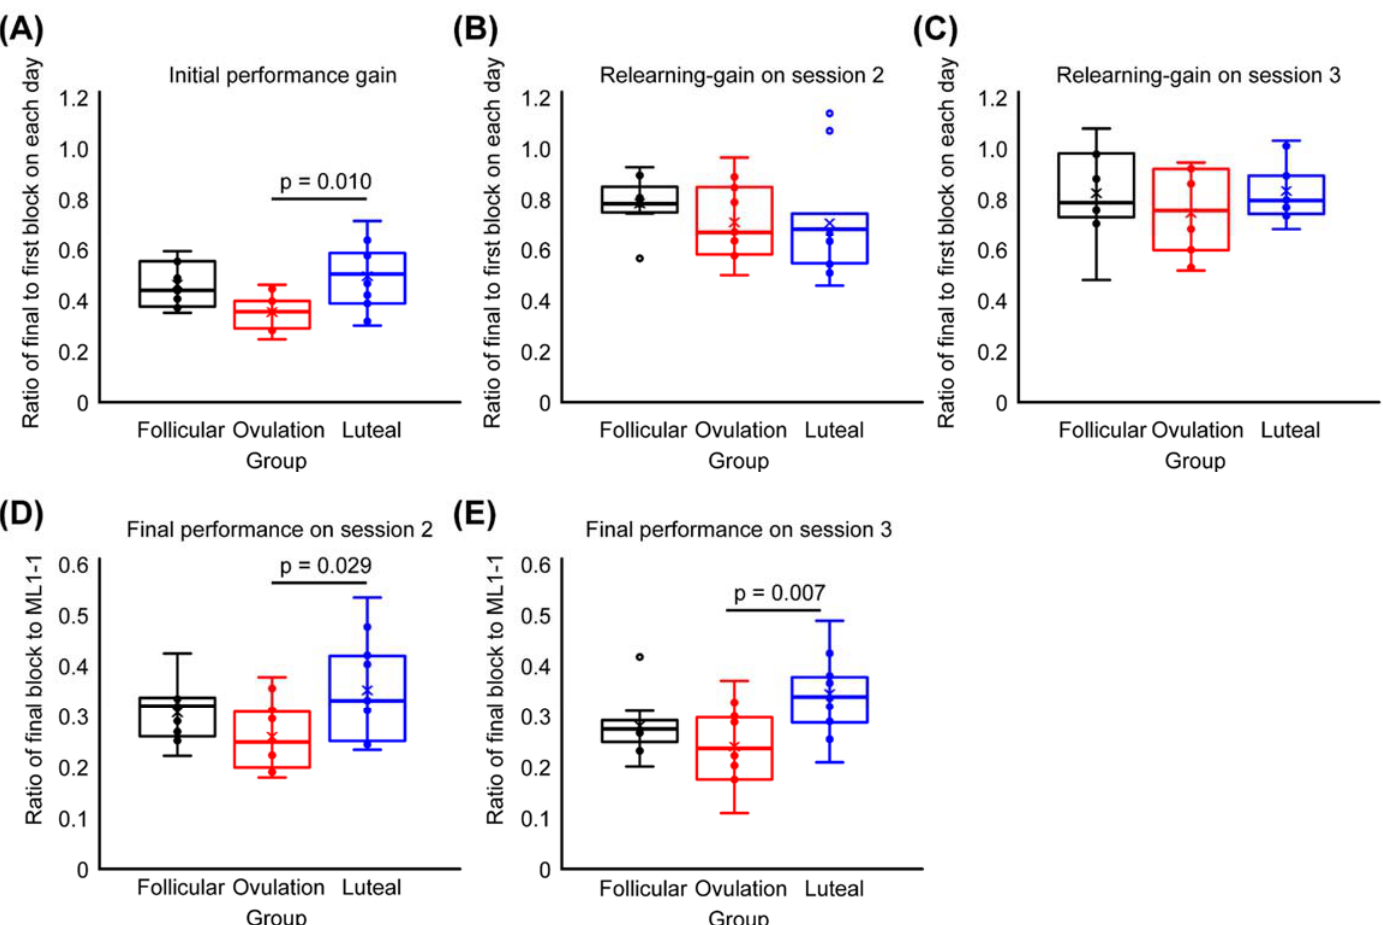
Figure 5. Performance gain during initial ML and overlearning and final performance on each day. ( A ) shows initial performance gain during Session 1. There was lower initial performance gain in the luteal group than in the ovulation group. ( B , C ) present the overlearning gain during Sessions 2 and 3; there were no differences among the three groups. ( D , E ) show significantly lower final performance in the luteal group than in the ovulation group during Sessions 2 and 3. These results indicated that the initial performance gain during Session 1 influenced task performance not only on the next day but also 1 week after the initial ML.